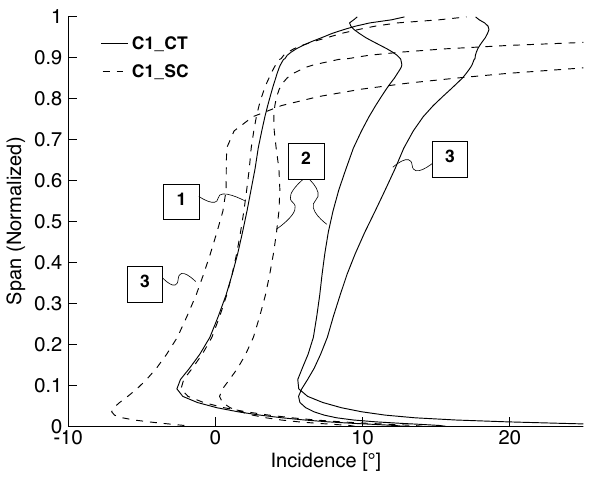
Figure 12. Averaged incidence angle at C1 impeller inlet; results from unsteady RANS simulations of 75% rotational speed (cf. Figure